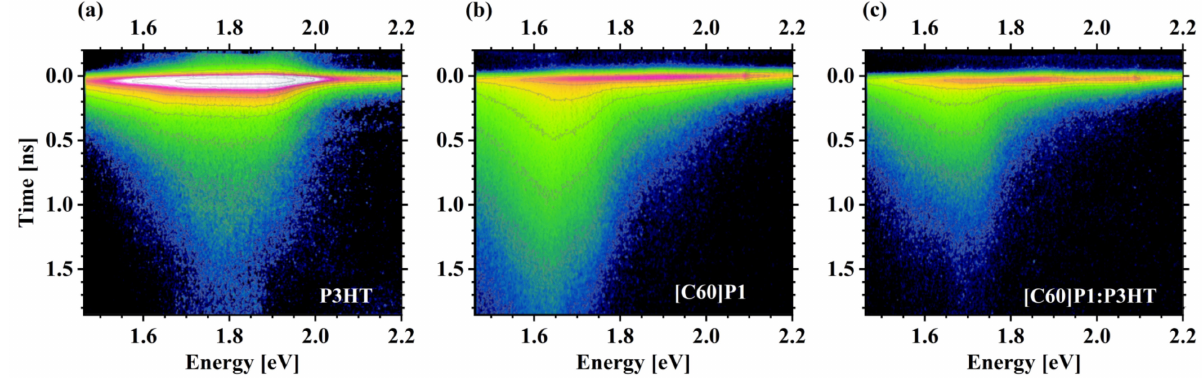
Figure 7. TRPL spectra of ( a ) P3HT, ( b ) [C60]P1, and ( c ) blend of [C60]P1 and P3HT at 3:2 molar ratio. Apparently, the luminescence of the blend is weaker and decays faster than those of the components. The plotted data are contour maps of luminescence intensity as a function of time (vertical scale) and energy (horizontal scale). The intensity is plotted in a logarithmic scale, so the intensity from contour to contour grows e times (where e is the Euler